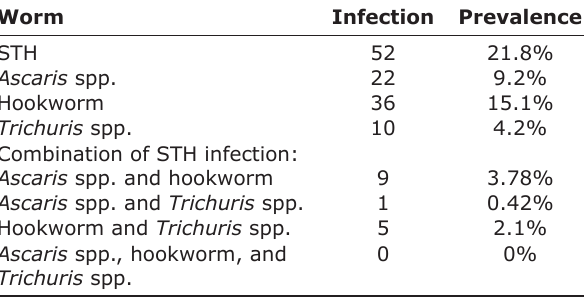
Table-1: STH infection in traditional pig farmers in